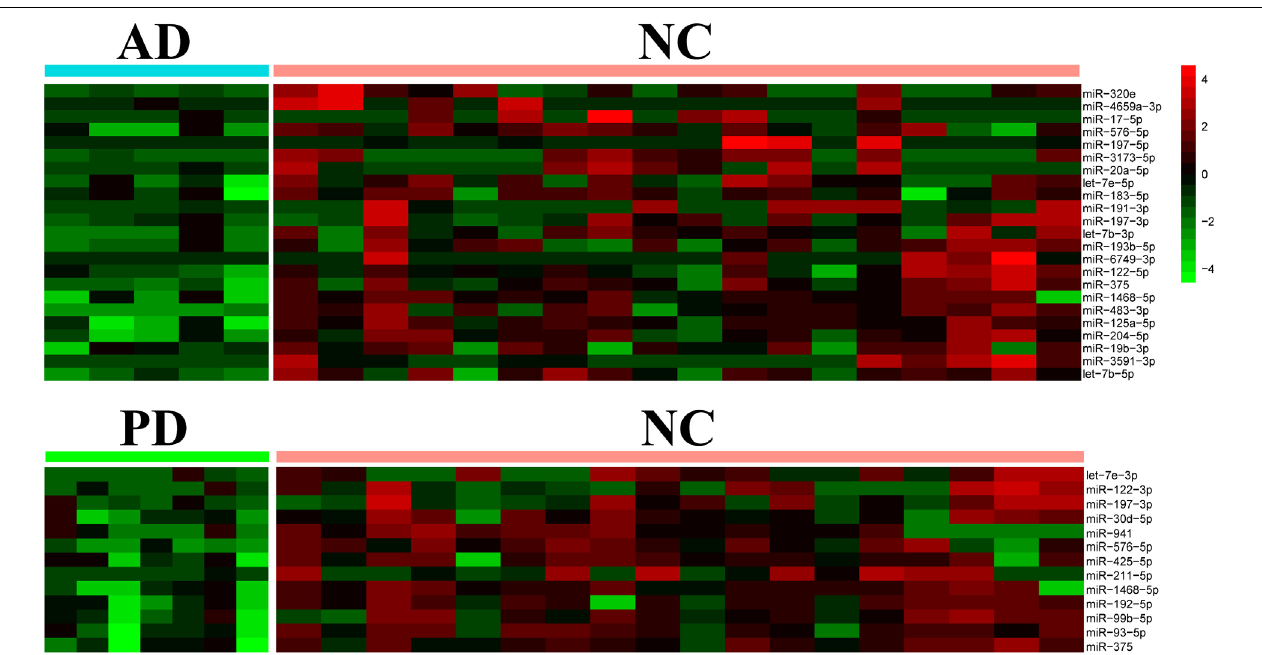
FIGURE 2 | Heatmap of differential expression levels of miRNAs in AD and PD patients. The color scale shown on the right illustrates the expression level (log 2 ) of a miRNA across all samples. Each row represents significantly declined miRNAs ( p < 0.05) in AD or PD patients including 23 declined miRNAs in AD patients and 13 declined miRNAs in PD patients.